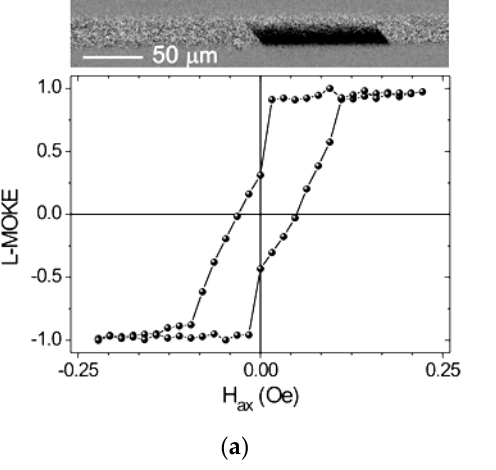
Figure 3. MOKE hysteresis loops and surface domain structures ( a ) Hax = 0.04 Oe, H CIRC = 0; ( b ) Hax = 1.25 Oe, H CIRC = 0.6 Oe. Reprinted with permission from [89]. The application of the circular magnetic field transforms the MOKE hysteresis